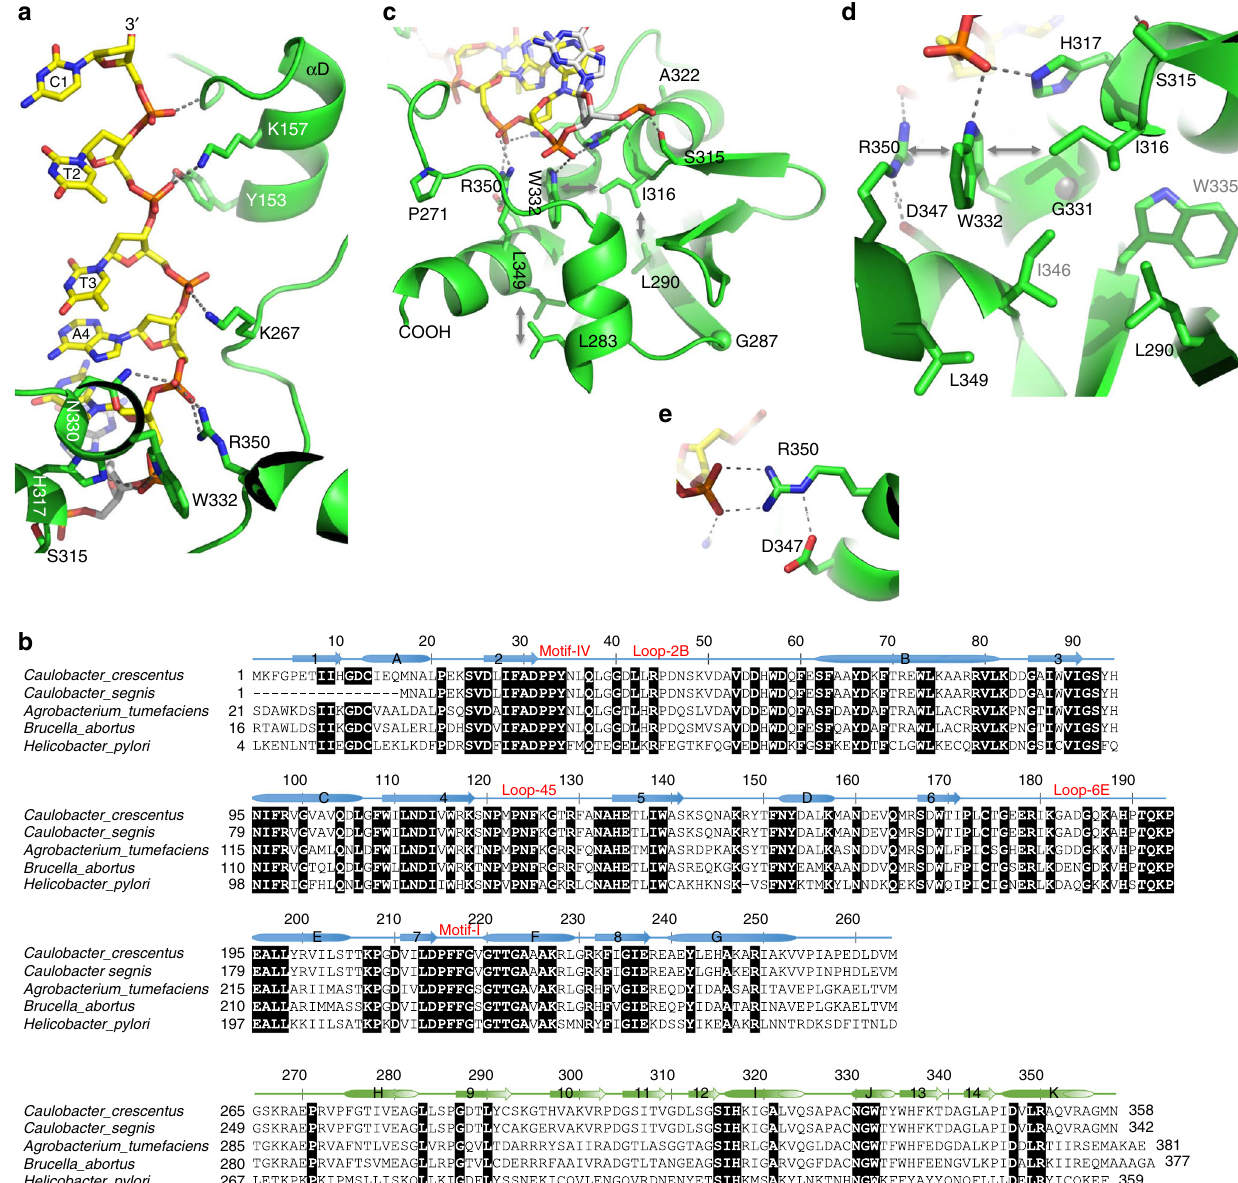
Fig. 5 Sequence conservation of CcrM orthologs. a Molecule B (helix α D and C-terminal domain) provides almost all DNA phosphate interactions along the non-target strand. b Sequence alignment of fi ve CcrM orthologs: Caulobacter crescentus (NC_002696), Caulobacter segnis (NC_014100.1), Agrobacterium tumefaciens (NC_003062), Brucella abortus (AF011895), and Helicobacter pylori (AGR62562). Invariant residues are marked with white letters on black background. c-e Structural features of invariant residues in the C-terminal domain. c Pro271 and Gly287 are structural residues located in the linker loop and the beginning of strand β 9. d Leu283, Leu290, Ile316, Gly331, Trp332, and Leu349 are part of the hydrophobic core that supports the integrity of the C-terminal domain. e Asp347 and Arg350 form an electrostatic